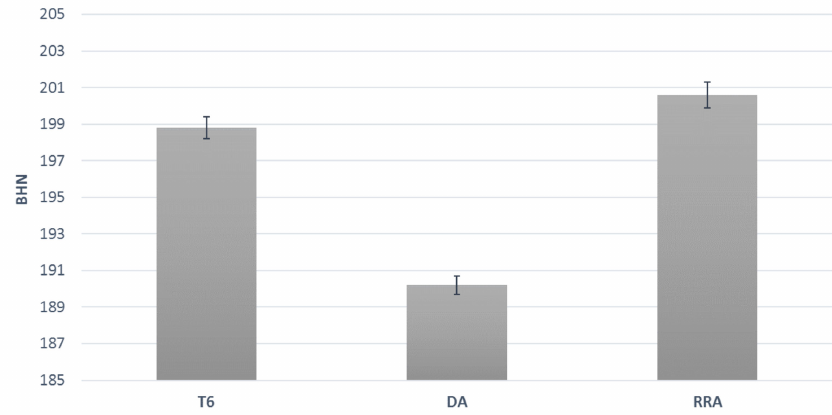
Figure 2. Results of hardness measurements of AW7075 alloy after heat